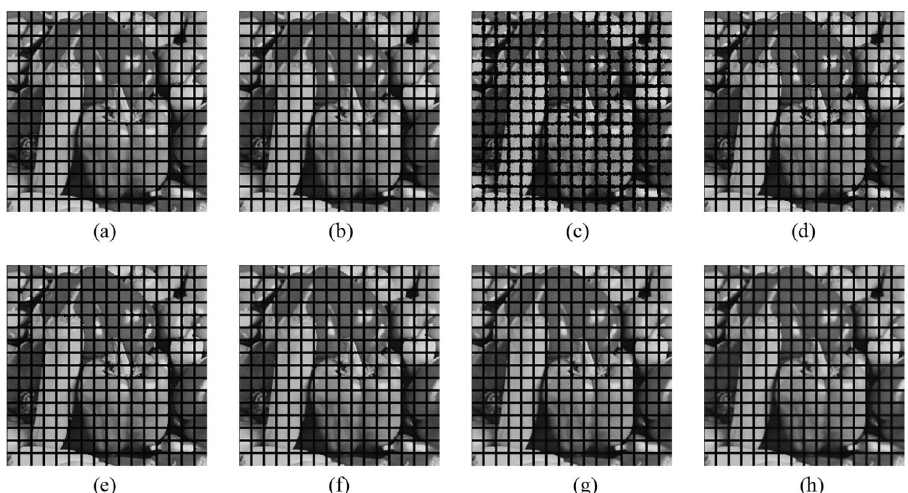
Figure 36. Comparison of edge preservation performance of each filter (“Pepper”). ( a ) Grid-added image; ( b ) filtered image using abwFMGFI; ( c ) filtered image using FMGFI (BW = 1 level); ( d ) filtered image using FMGFI (BW = 3 level); ( e ) filtered image using FMGFI (BW = 5 level); ( f ) filtered image using FMGFI (BW = 11 level); ( g ) filtered image using FMGFI (BW = 21 level); ( h ) filtered image using FMGFI (BW = 51 level).